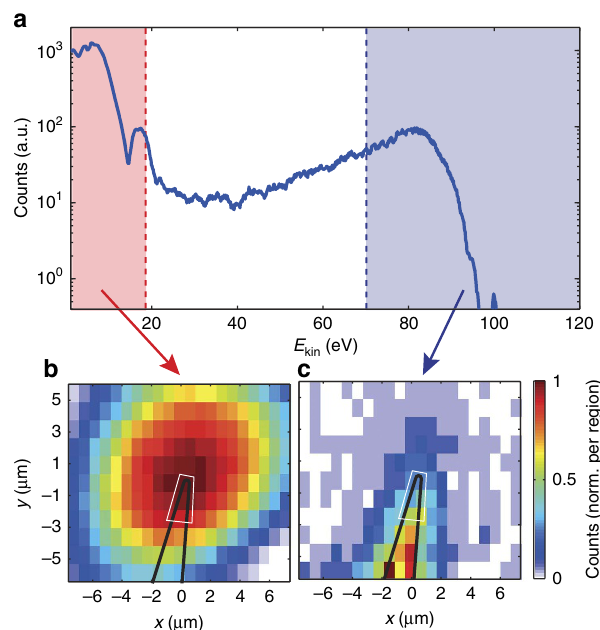
Figure 2 | Position scan with photoelectron spectra from the Au nanotaper. ( a ) Electron spectrum under combined illumination with XUV and NIR light, measured using a time-of-flight spectrometer. For the polycrystalline nanowire, the energy landscape under the Fermi edge results from averaging over different crystal structures and orientations, and eventually a contribution from surface contamination. ( b ) Integrated electron emission maps from the low-energy region of a dominated by strong-field NIR photoemission and ( c ) for the high-energy region of a caused by linear XUV photoemission. The laser beam propagates in the z direction. The NIR photoemission is strongly enhanced at the apex of the nanotaper, where field enhancement at the apex supports non-linear NIR photoemission processes. The XUV photoemission represents the convolution of the taper geometry with the XUV beam in the focus. The solid black line serves as a guide to the eye showing the outline of the nanotaper, while the solid white line illustrates approximately the geometry of the part of sample that is probed in the experiment. Calculations show that relative amplitude and phase of the electrical field is approximately homogenous over the probed surface region and accordingly averaging preserves results on relative phase and amplitude of the field (Supplementary Note 6; Supplementary Figs